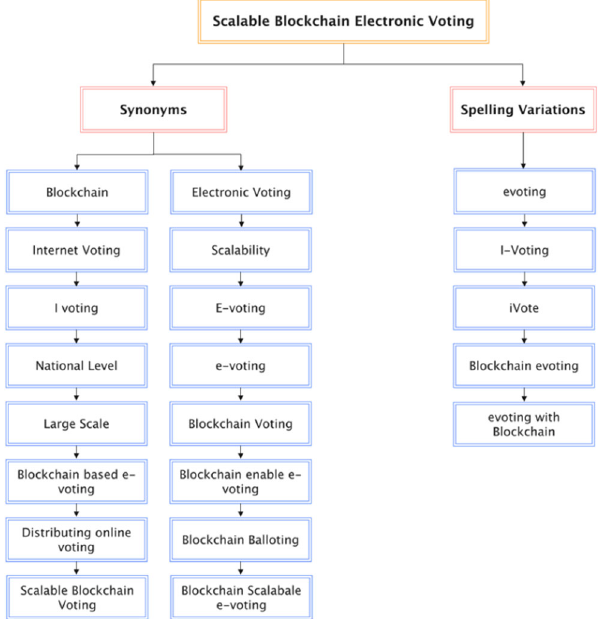
Figure 7. Terms that form the search string . Table 3. Query strings table .